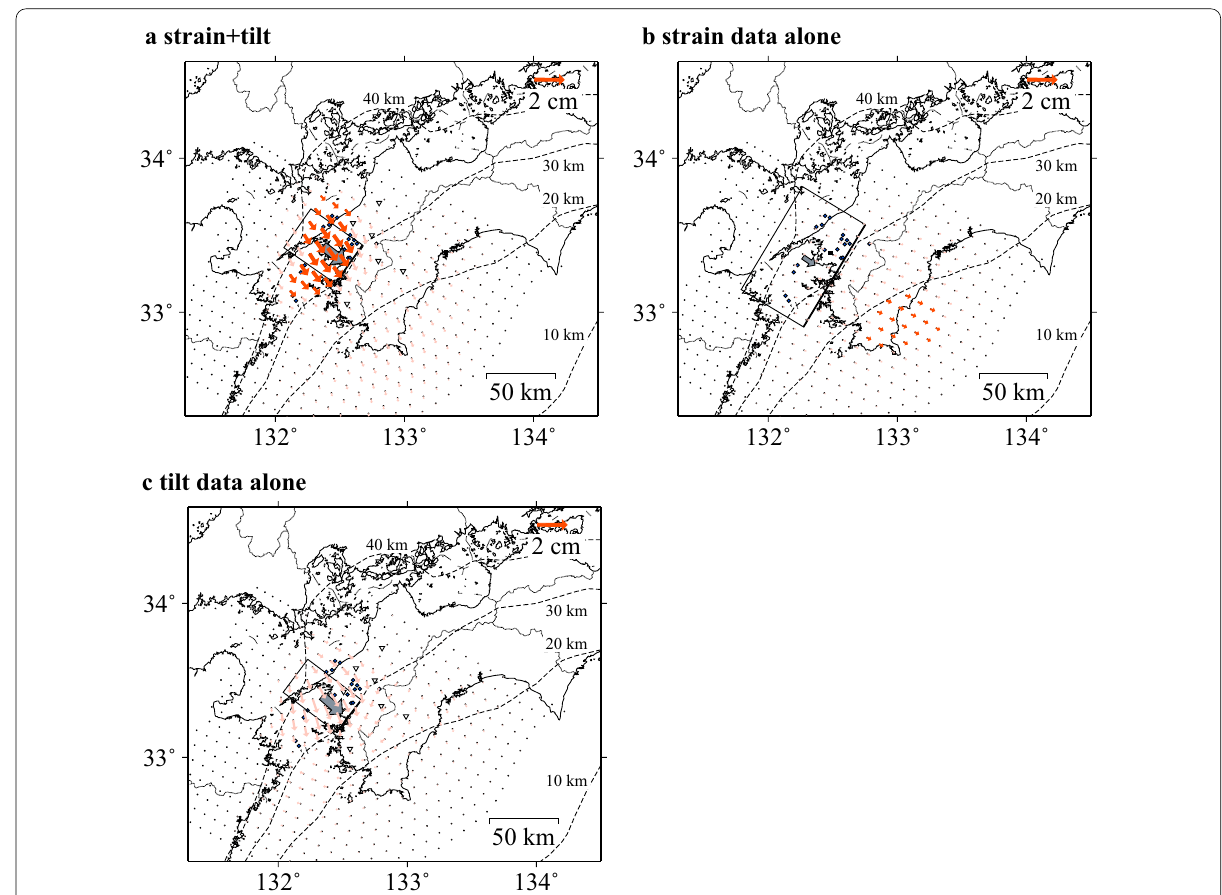
Fig. 17 Estimated slip distribution during 23–27 October 2016. Map region corresponds to Area C in Fig. 1. a Surface projection of the estimated slip distribution on the plate interface (arrows) and rectangular fault model (rectangle and gray arrow) based on strain and tilt data. Slips exceeding the standard deviation (1 σ ) are shown in red and slips below the 1 σ are shown in light pink. Colored dots indicate LFT epicenters in this period (see Fig. 15). Dashed contours indicate the depth of the Philippine Sea plate. b Surface projection of the estimated slip distribution on the plate interface and rectangular fault model based on strain data alone. c Surface projection of the estimated slip distribution on the plate interface and rectangular fault model based on tilt data